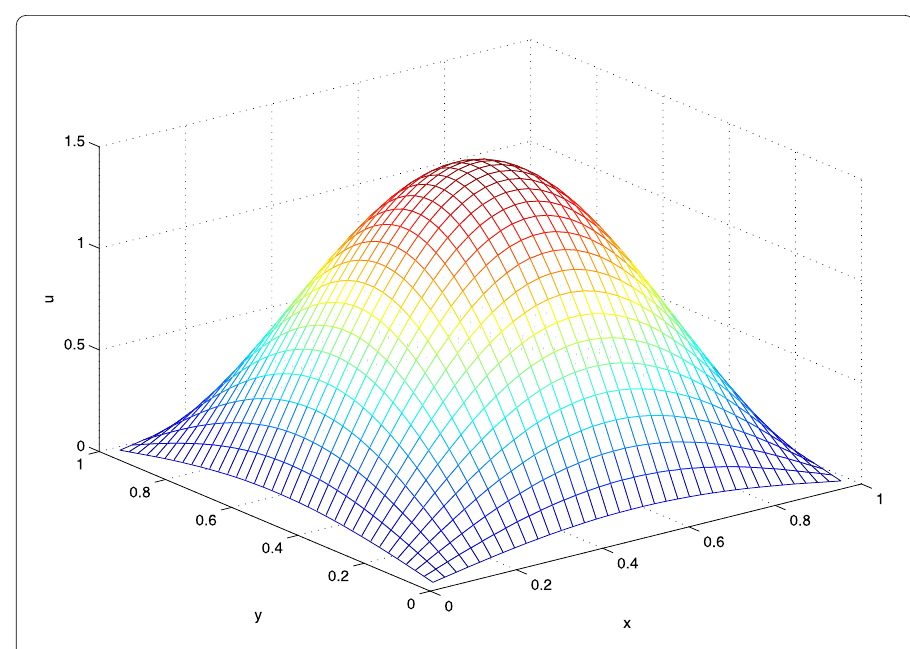
Figure 4 The numerical solutions for r = 1.0, h = 1/37 at t =